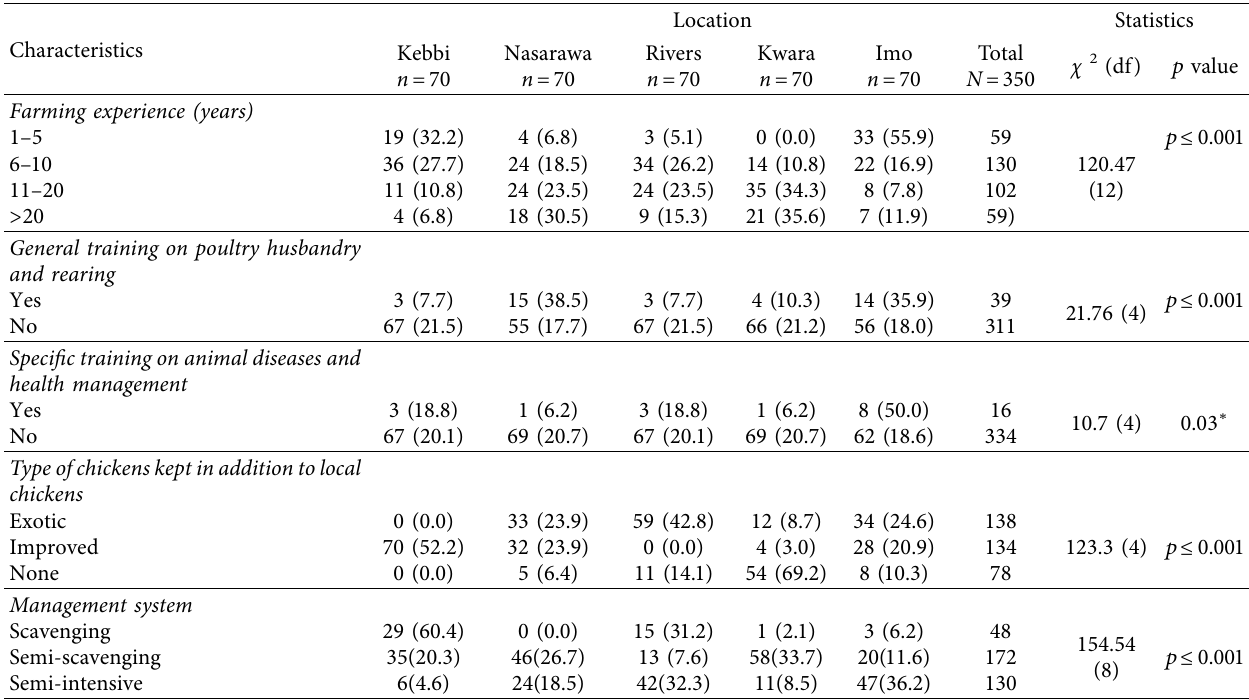
Table 3: Features of the poultry production and management system.